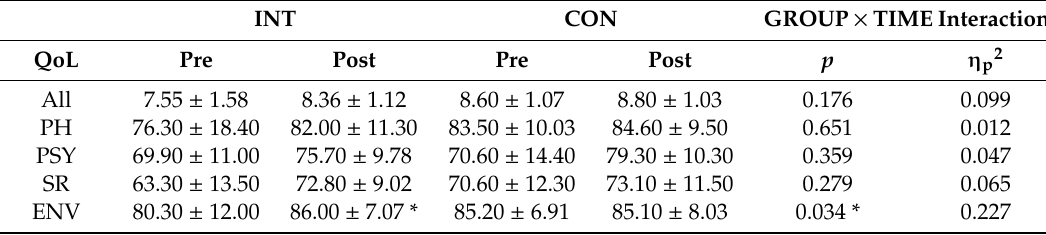
Table 4. Reported QoL data of INT and CON groups. Data (pre, post) are provided as means with standard deviations (SD). The p -values are calculated with the analyses of variance (ANOVA) and e ff ect sizes are given as partial eta squared ( η p2). INT CON GROUP × TIME Interaction QoL Pre